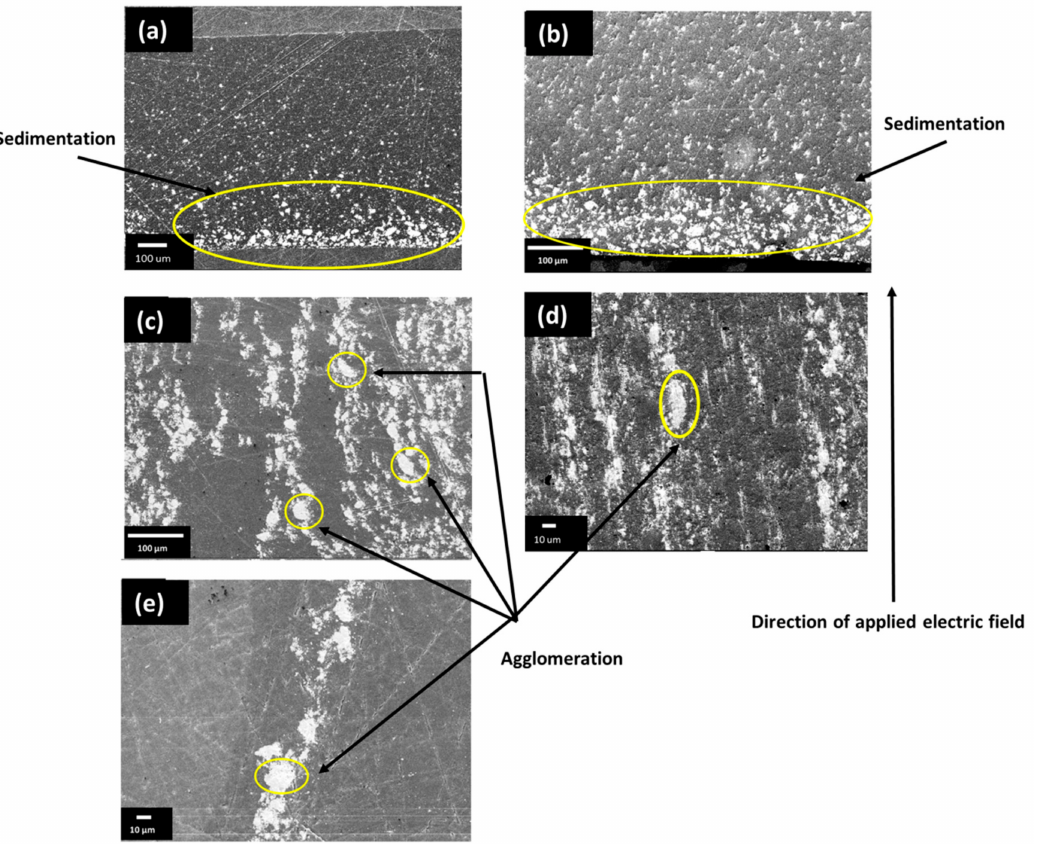
Figure 3. ( a , b ) Lead zirconium titanate-polymerized CBT (PZT–pCBT) composite without application of electric field; ( c , d ) structured PZT–pCBT composite; and ( e ) magnified image of structured PZT–pCBT